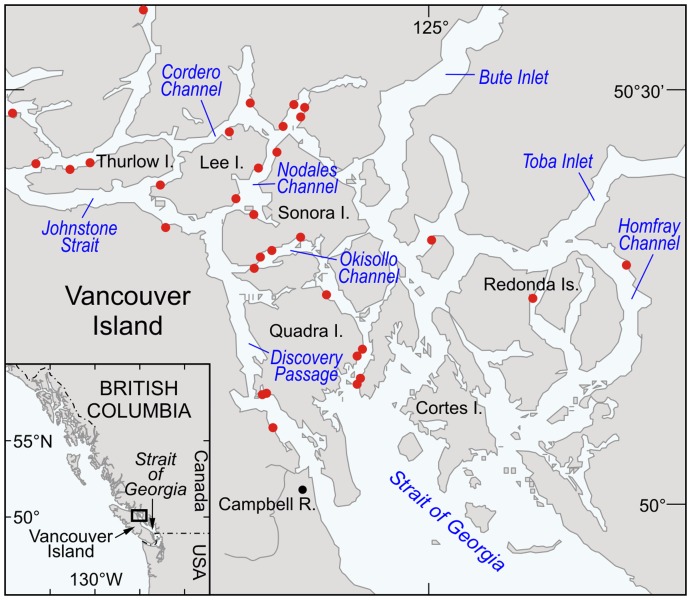
Map depicting Discovery Islands, British Columbia, Canada, with location of salmon aquaculture sites marked by filled (red) circles.